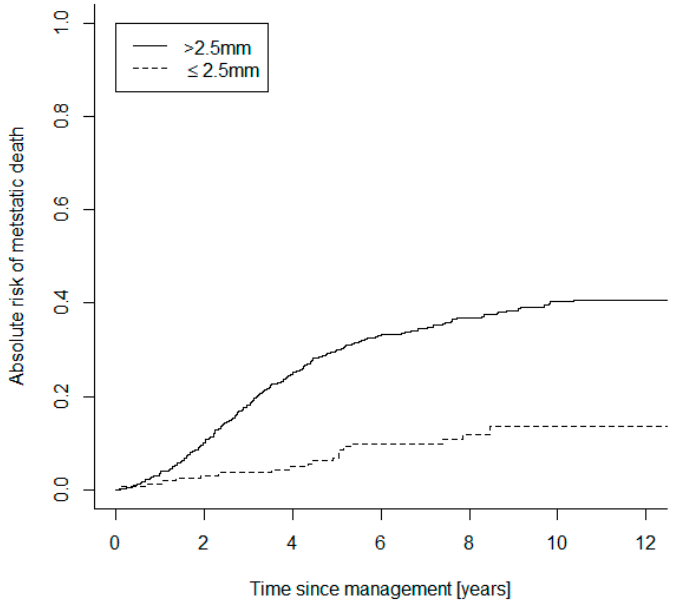
Figure 2. Curves showing the comparative absolute risks of mortality due to metastatic UM subdivided into the defined ‘small’ and ‘large’ categories.